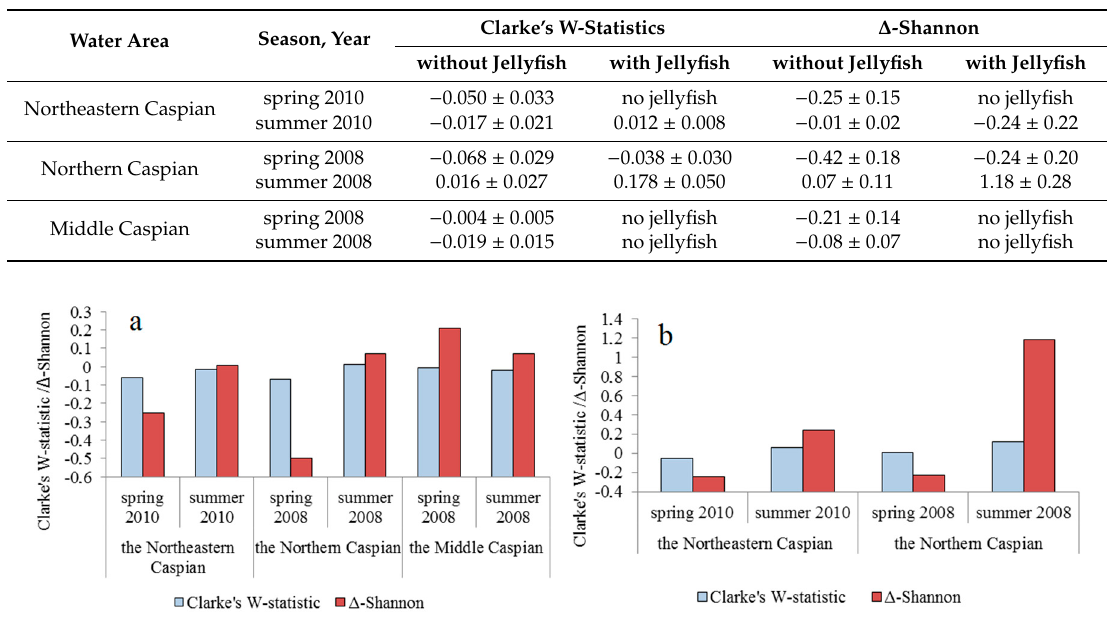
Figure 4. Seasonal changes in the values of Clarke’s W-statistics and for holoplankton ( a ) and zooplankton ( b ) in the surveyed waters of the Caspian Sea.